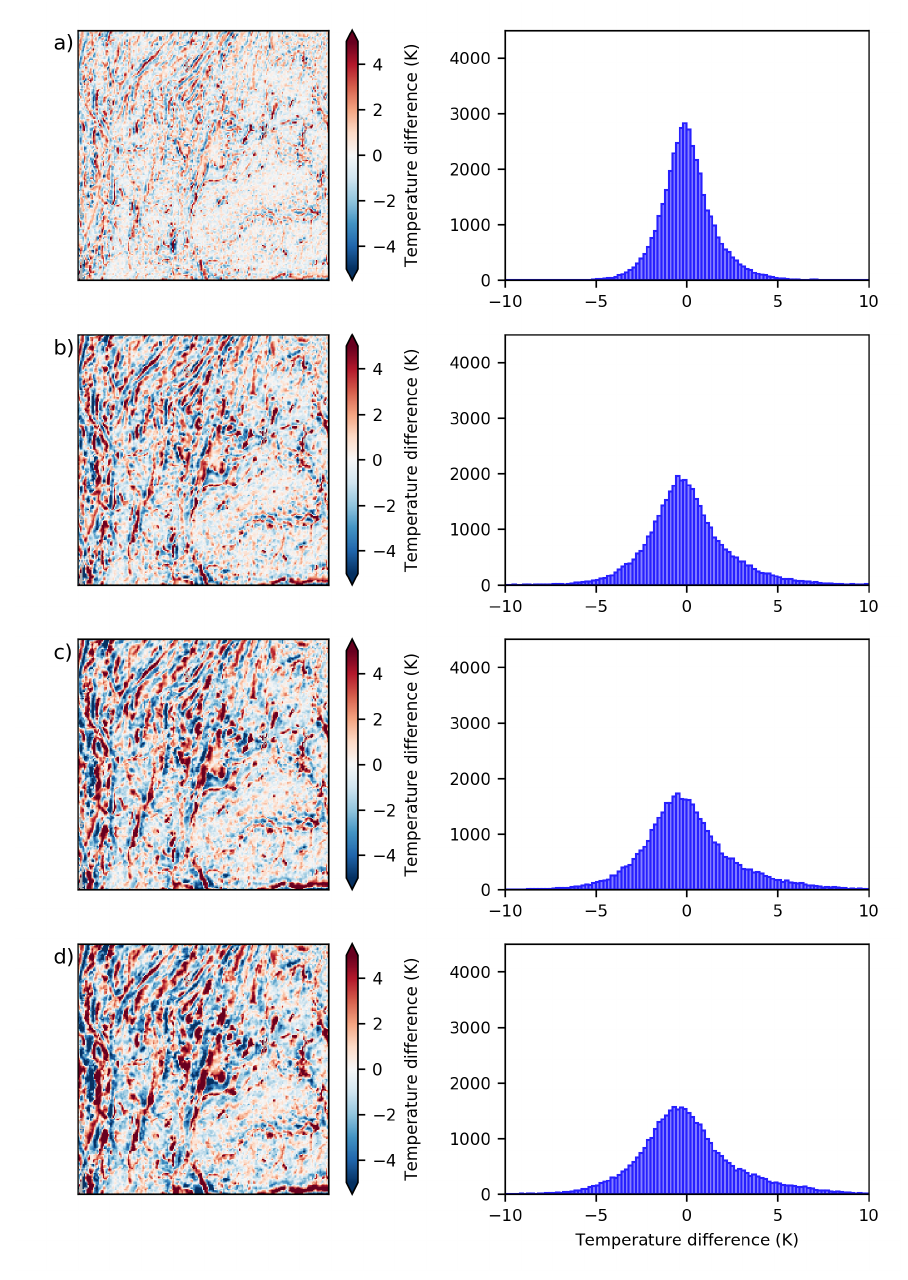
Figure A6. Changes in the spatial and statistical distribution of temperature estimates for the central Thailand (thl) study area by window size. Window levels shown are ( a ) 5 × 5 window; ( b ) 7 × 7 window; ( c ) 9 × 9 window; and ( d ) 11 × 11